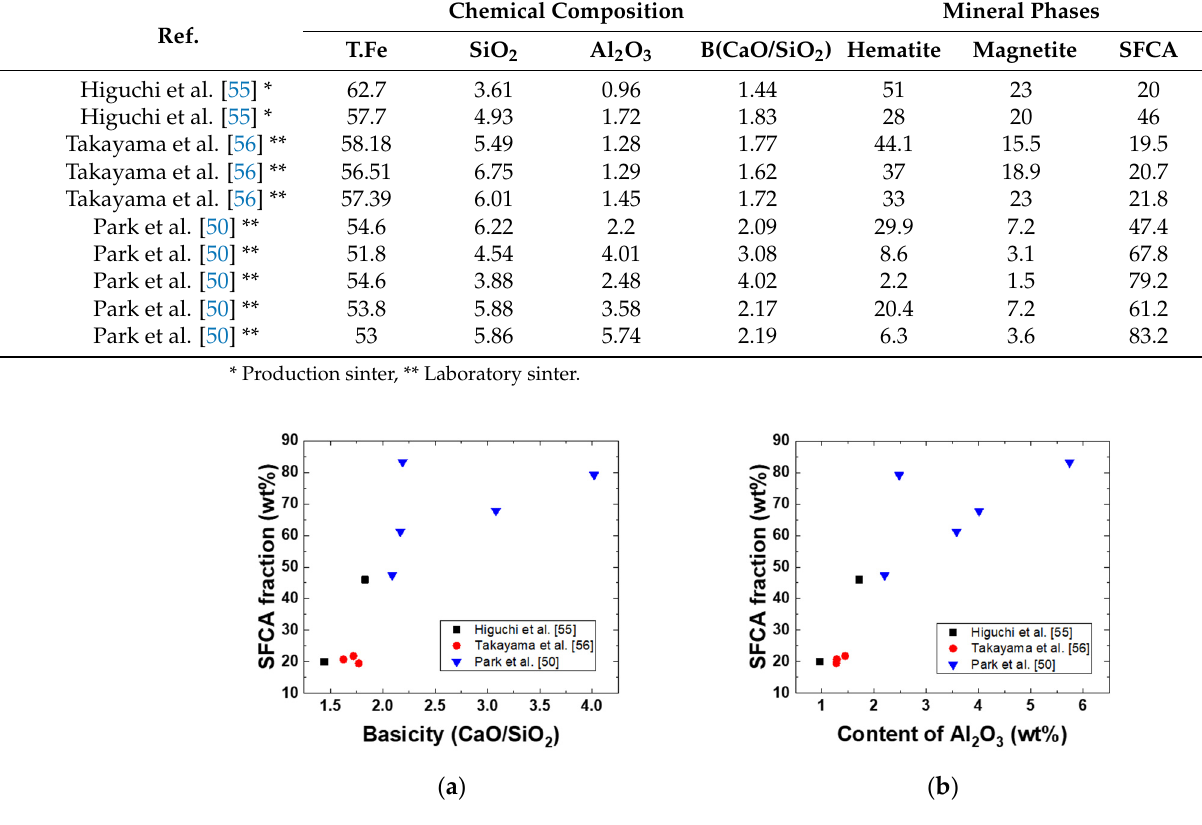
Figure 6. Effects of ( a ) basicity (CaO/SiO 2 ) and ( b ) Al 2 O 3 content on the SFCA fraction in the iron ore sinter.